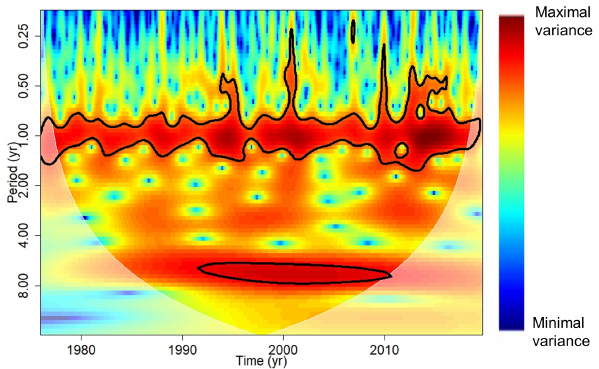
Figure 3. Example of CWT applied to the borehole of Pihen-Lès- Guînes. On the spectrum, time is indicated on the x axis, period or scale on the y axis, and amplitude (or variance, or power) on the z axis. The contour lines express the statistically significant regions of the spectrum at a confidence level of 95% (Monte Carlo test). The white transparent line corresponds to the cone of influence where the variance is underestimated due to edge